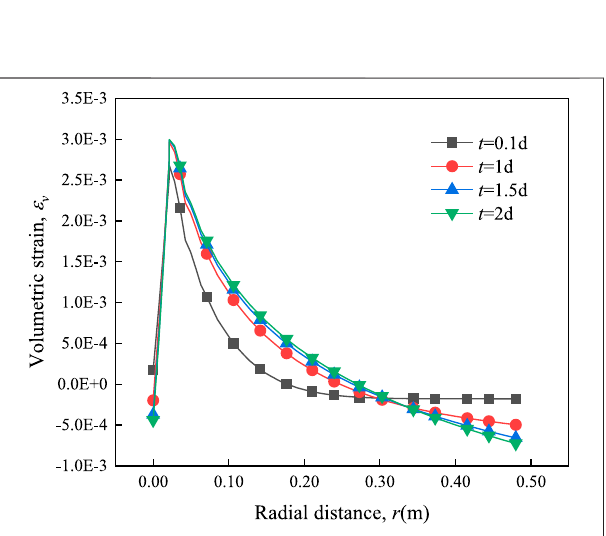
FIGURE 11 | Variation law of volumetric strain with radial distance at different times at height z = 0.25 m.